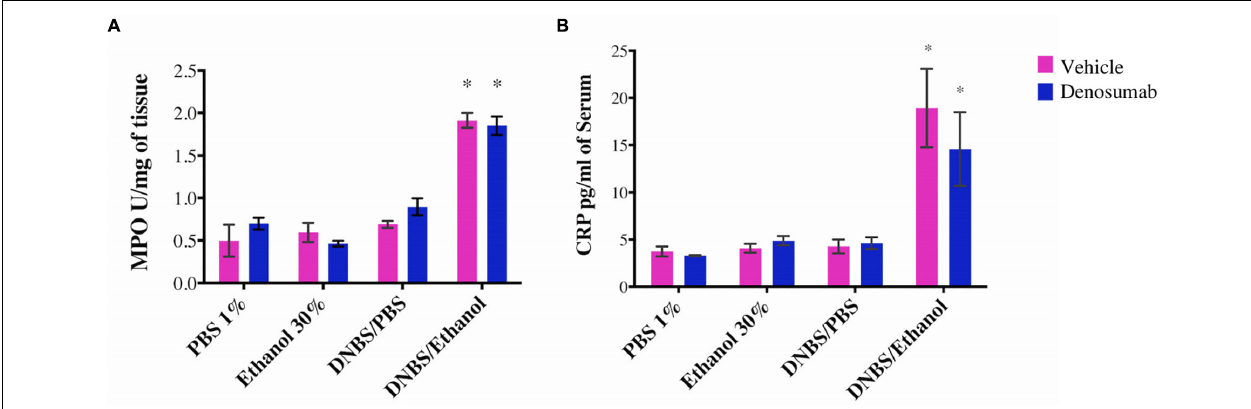
FIGURE 4 | The effects of DNBS/Ethanol-induced colitis and denosumab treatment on regulating the colonic MPO activity and serum CRP. DNBS/Ethanol significantly increased (A) . Colonic MPO activity and (B) . Serum CRP. Denosumab did not ameliorate the negative effects of DNBS/Ethanol-induced colitic conditions. Vehicle = PBS 1%. Error bars are shown as SEM. * p < 0.001 when compared with other induction models within the denosumab or vehicle group, is calculated using SAS MIXED procedure and illustrated by Prism using two-way ANOVA. n = 6 mice per